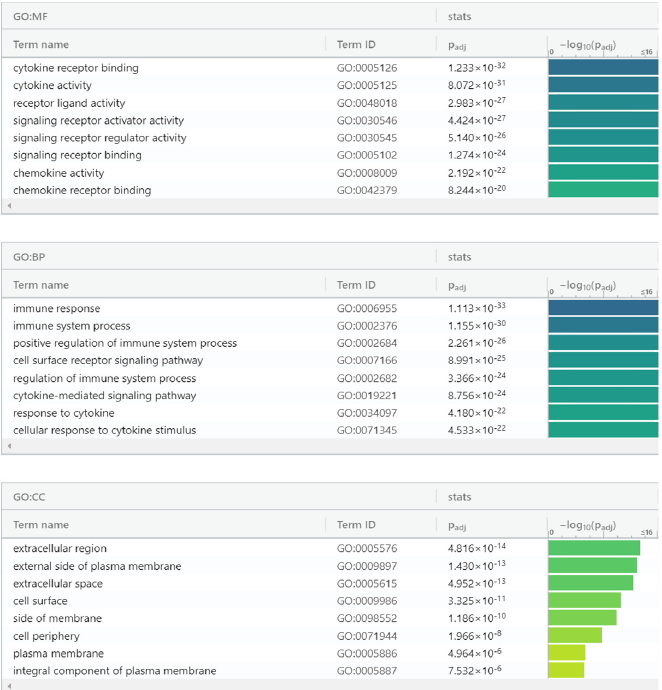
Figure 7. gProfiler classification of Immuno-oncologic panel proteins in the EC serum according to their molecular function, biological processes, cellular component.